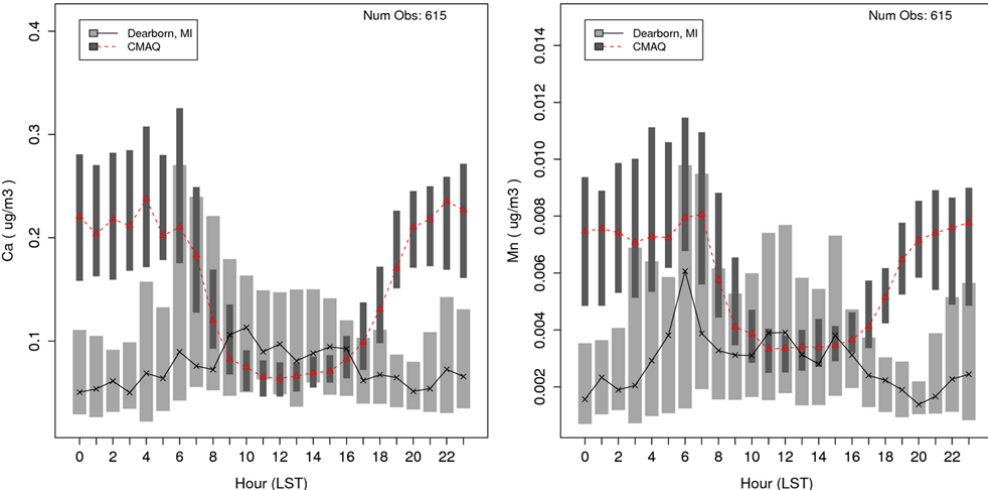
Fig. 4. Boxplots of observed (solid black; light shading) and CMAQ estimated (dashed red; dark shading) average diurnal concentrations (µgm − 3 ) of Mn (left) and Ca (right) for Dearborn, Michigan, for 13 July–11 August 2007. The lines represent the median, while the shading represents the 25th to 75th (interquartile) range of the